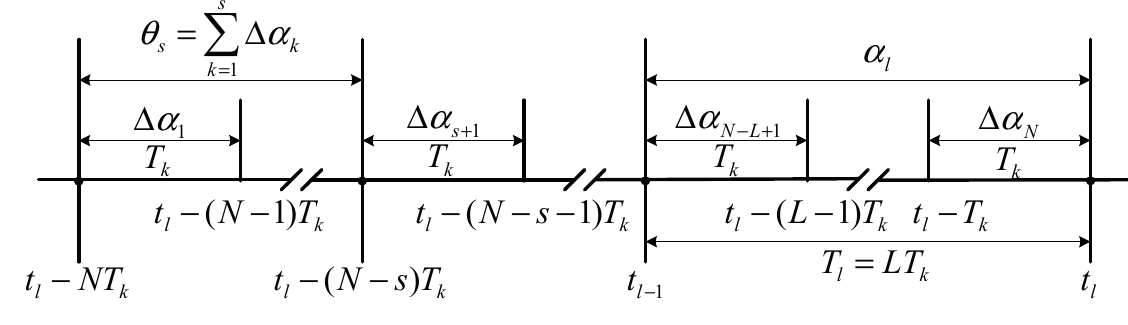
Figure 1. Distribution of several kinds of angular increment series against